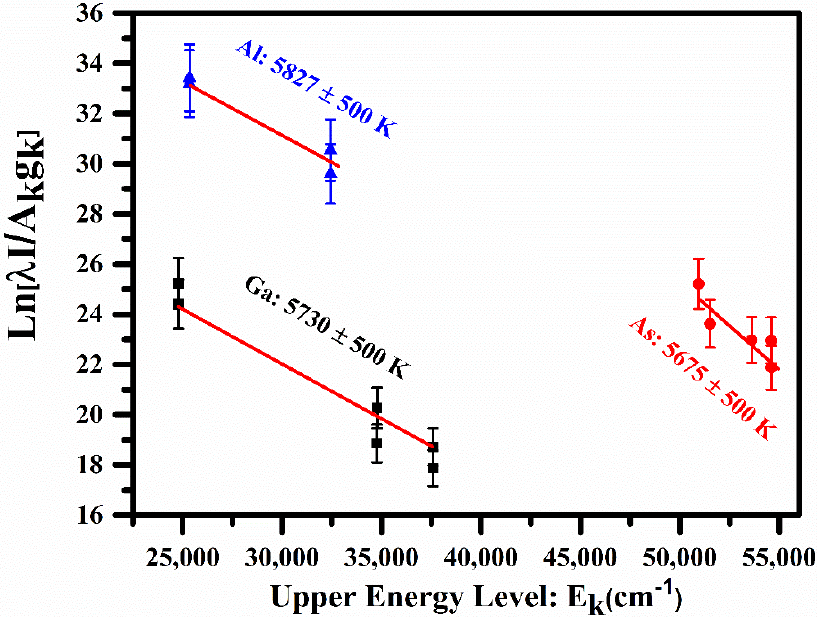
Figure 3. Typical Boltzmann plots for sample ‒ 1 using several neutral emission lines of Ga, As, and